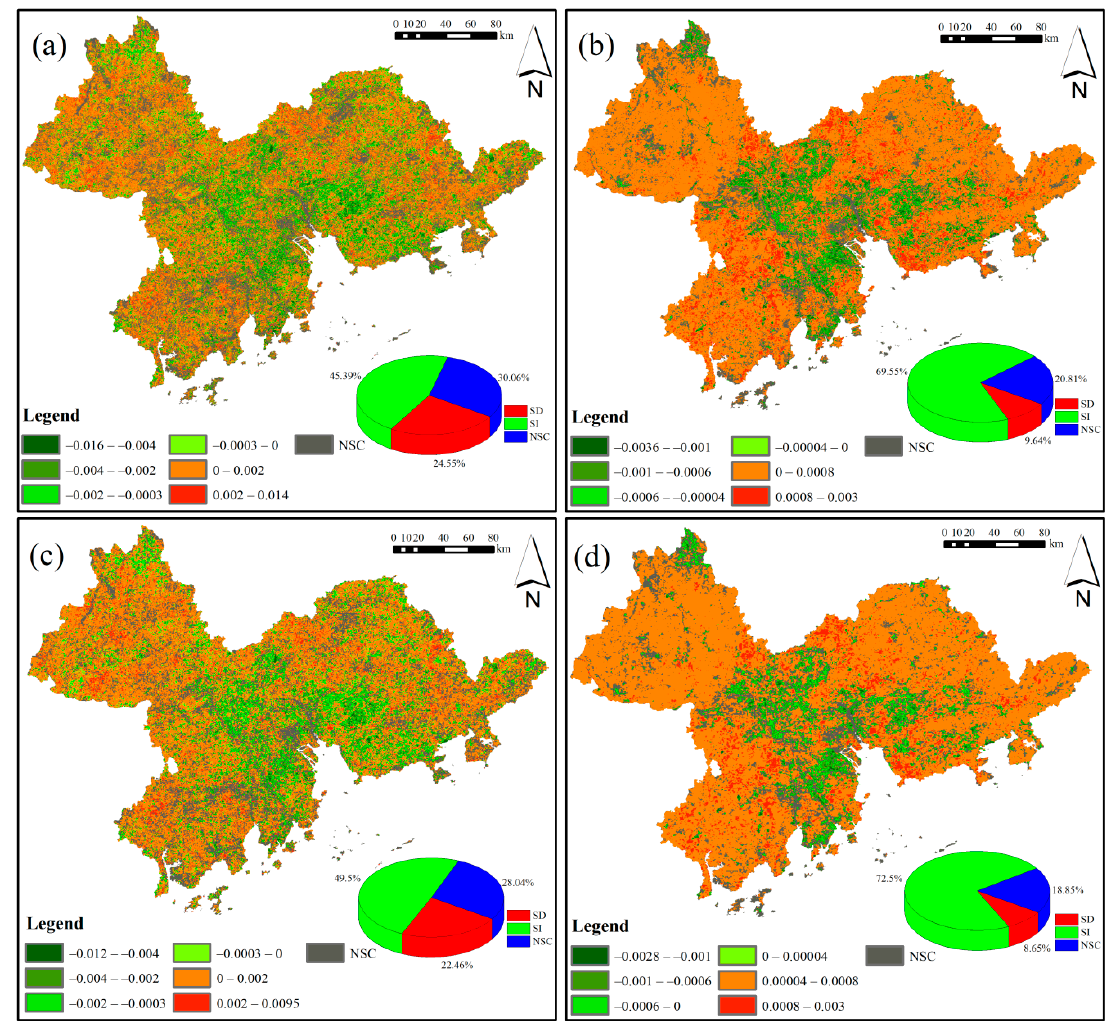
Figure 8. Comparison of ( a ) Q1-TR, ( b ) Q1-R, ( c ) A1-TR, ( d ) A1-R in the PRD; SD indicates significant decrease, SI indicates a significant increase, NSC indicates no significant change.